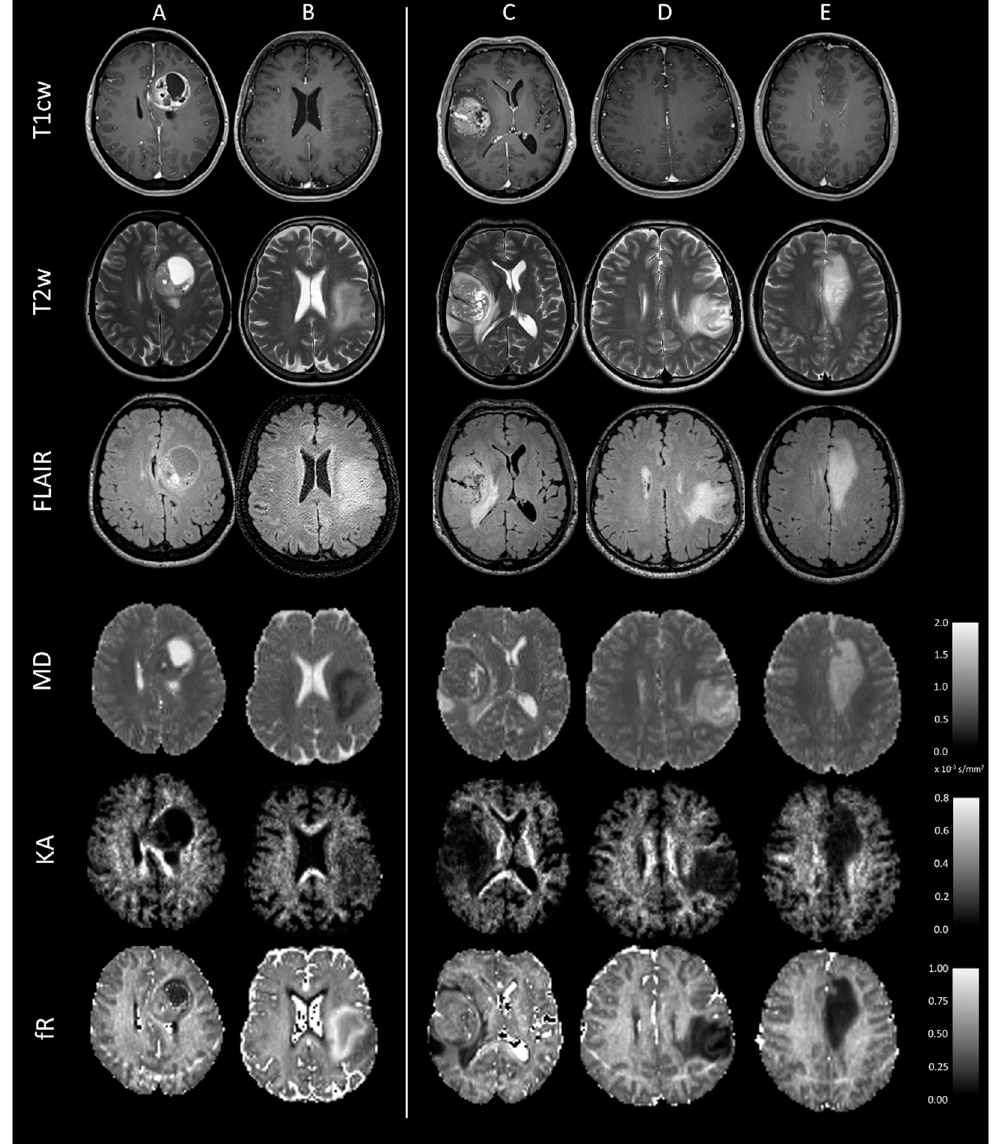
Figure 1. Axial T1cw, T2w, and FLAIR images and MD, KA, and fR maps at the level of the tumour are shown for five representative subjects with distinct molecular subtypes of adult-type gliomas. ( A ) Patient with IDH-wildtype glioblastoma: a necrotic central area is surrounded by a rim of enhancement following gadolinium injection with low MD and high KA and fR. This distinct radiologic appearance can help the network to distinguish this subtype from those with IDH-mutation. ( B ) Patient with molecular GBM: lack of enhancement and necrosis, but with low MD and high KA and fR. ( C ) Patient classified as grade 4 IDH-mutant astrocytoma according to WHO CNS5: radiological characteristics similar to an IDH-wildtype glioblastoma. ( D ) Patient with IDH-mutant astrocytoma: lack of enhancement and necrosis, with high MD and low KA and fR. ( E ) Oligodendroglioma with IDH-mutation and 1p/19q codeletion: lack or subtle contrast enhancement with high MD and low KA and fR. T1cw = post-contrast T1-weighted; T2w = T2-weighted; MD = mean diffusivity; KA = kurtosis anisotropy; fR = restricted fraction; GBM = glioblastoma; and WHO CNS5 = fifth edition of the WHO classification of the central nervous system